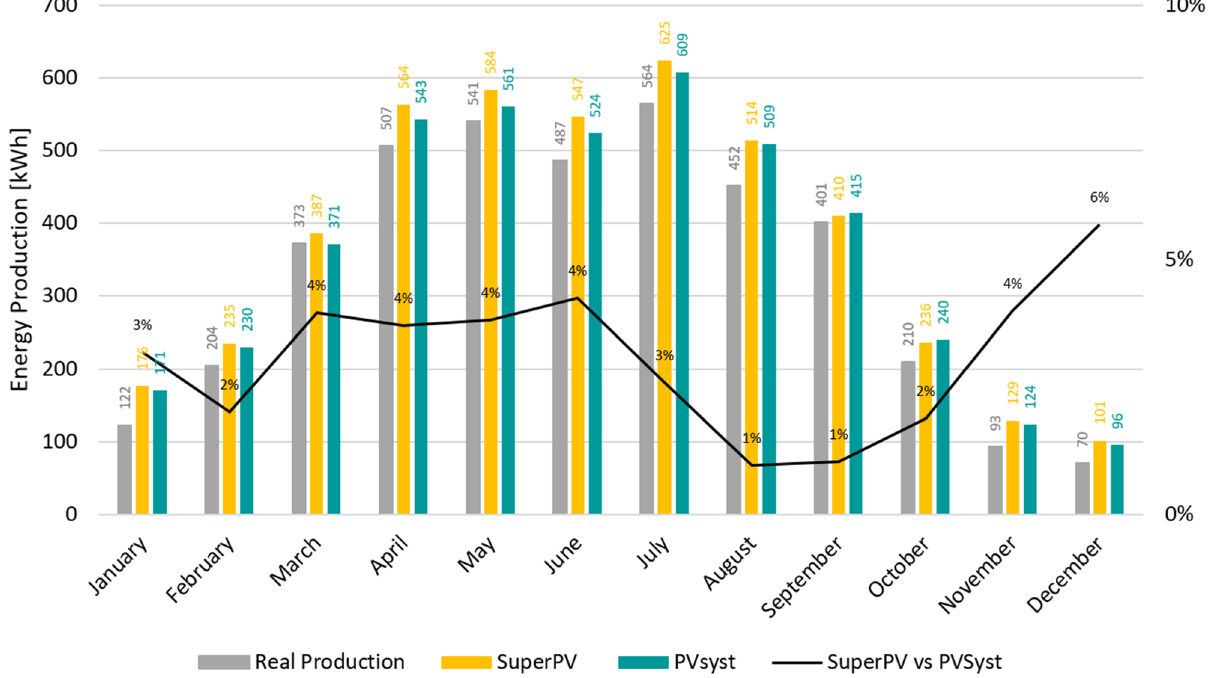
Fig. 11. Comparison among real PV production, SuperPV results, PVSyst